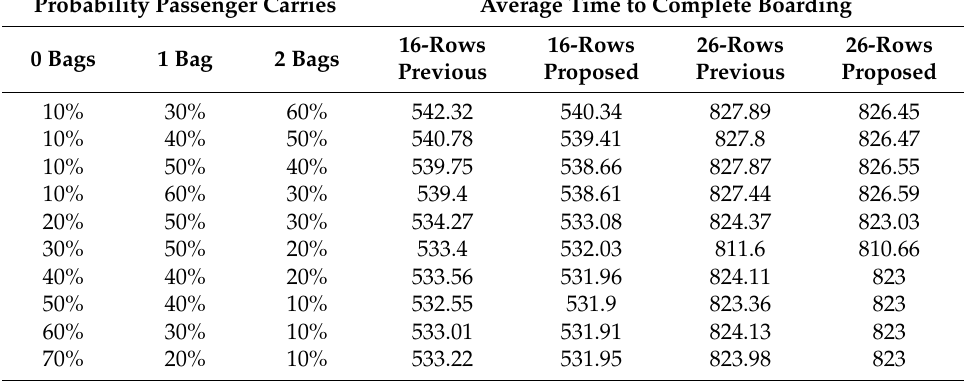
Table 7. Boarding time for the proposed method versus the previous method (scenario 2), varying